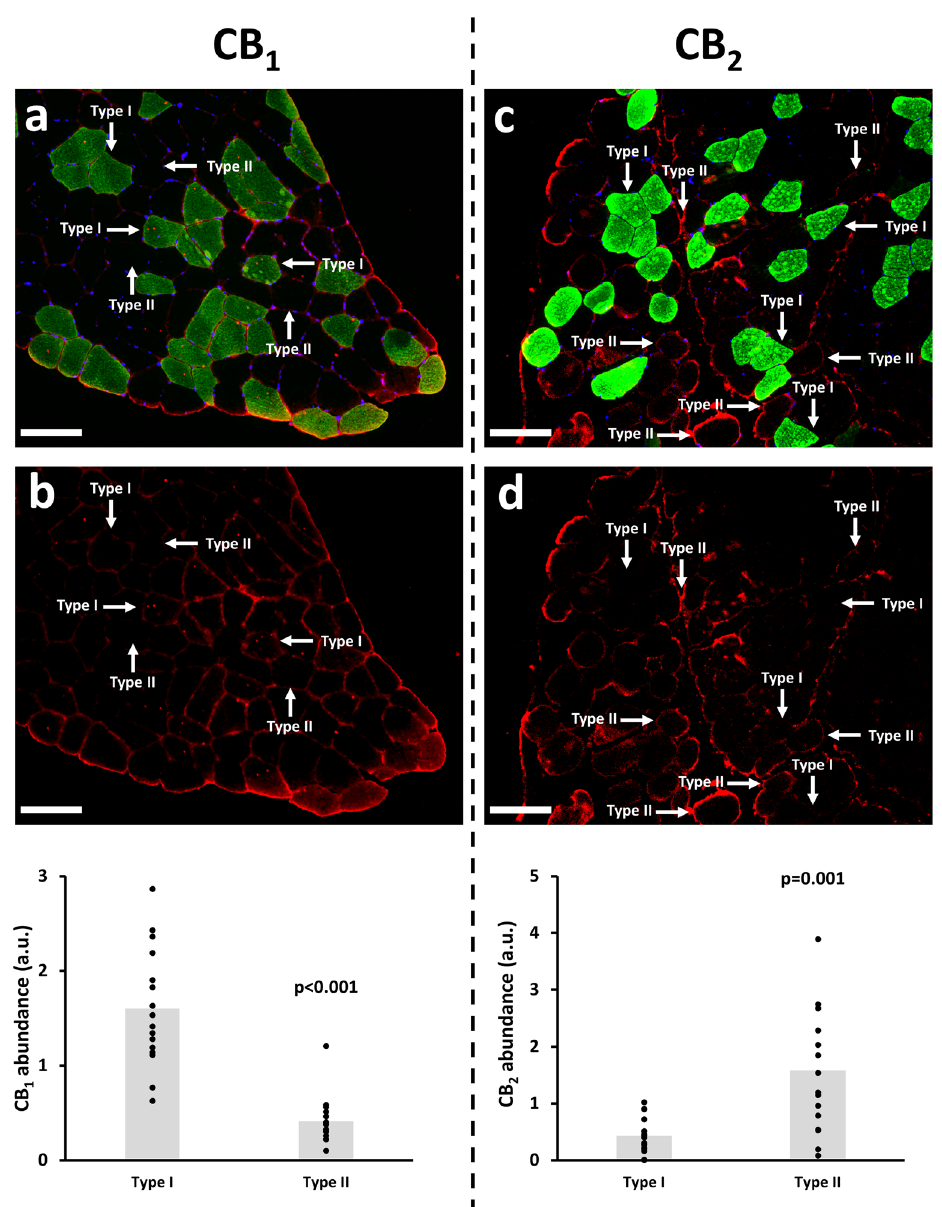
Figure 4. Representative muscle cryosections ( m. Vastus Lateralis ) stained for MyHC I (type I fibers; green), Hoechst (nuclei; blue),